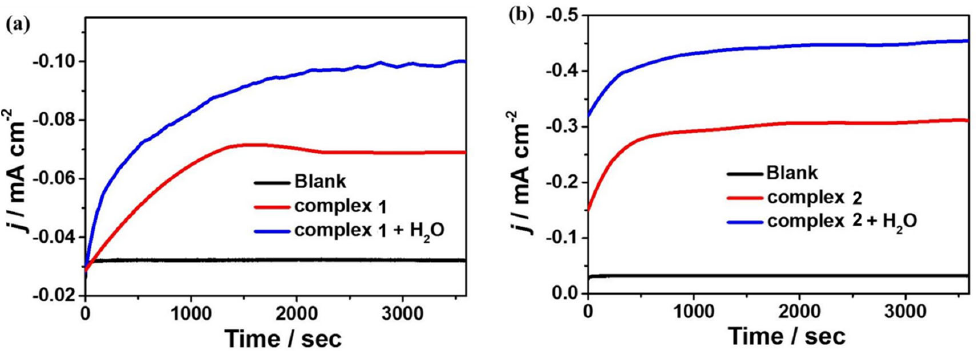
Figure 8. CPE curves of 0.5 mM complexes 1 ( a ) and 2 ( b ) in 0.1 M n Bu 4 NPF 6 DMF solution with and without H 2 O and 0.1 M n Bu 4 NPF 6 DMF solution without complex 1 or 2 .